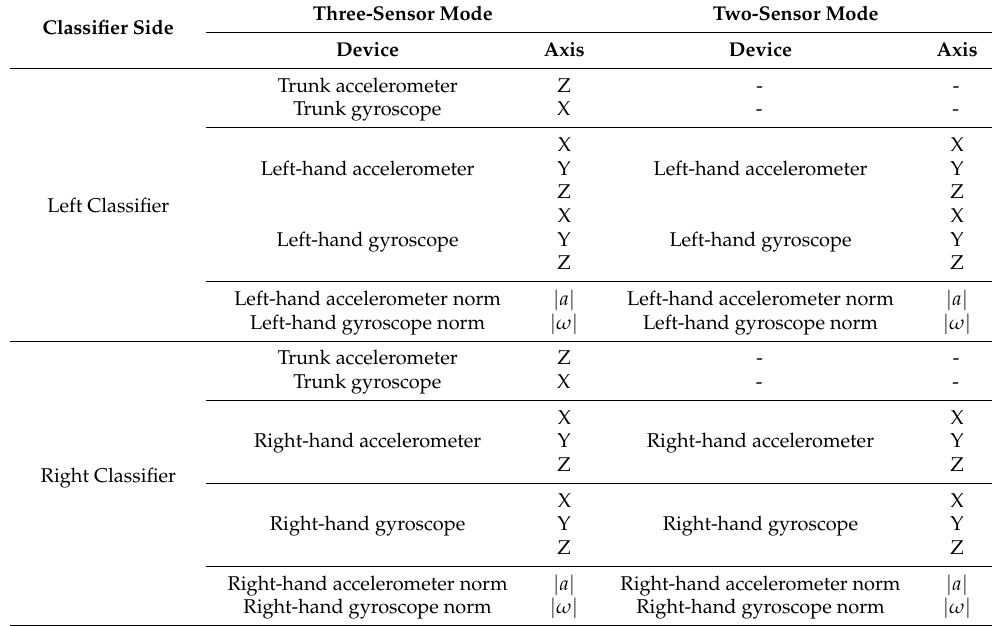
Table 2. Input variables for each classifier in both modes: three-sensor and two-sensor